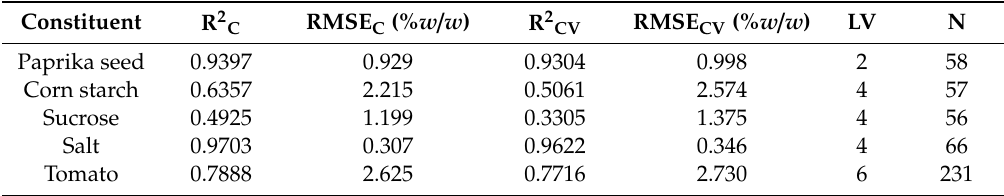
Table 12. Adulterant concentration prediction with PLSR and “LOOCV” validation on e-tongue sensor signals of authentic and adulterated tomato pastes after drift correction and outlier